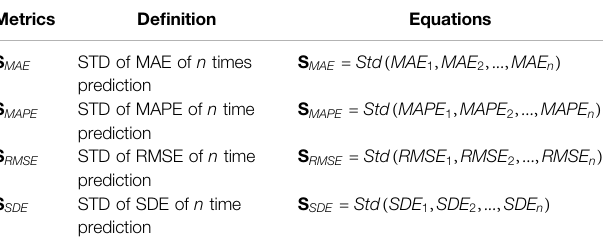
TABLE 8 | Four designed indicators of sensitivity